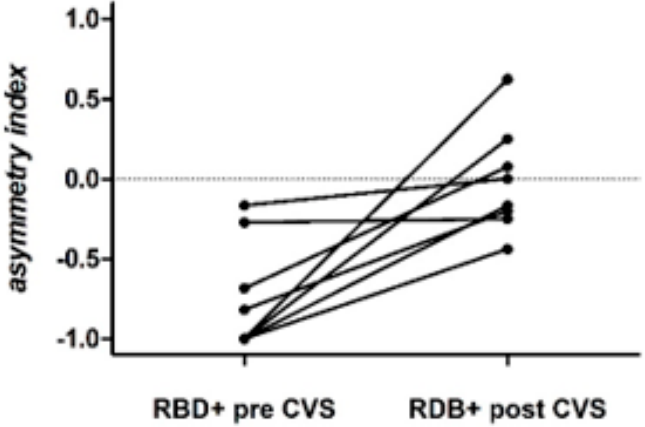
Figure 2. Asymmetry index data for each of the eight RBD+ patients before and after CVS .